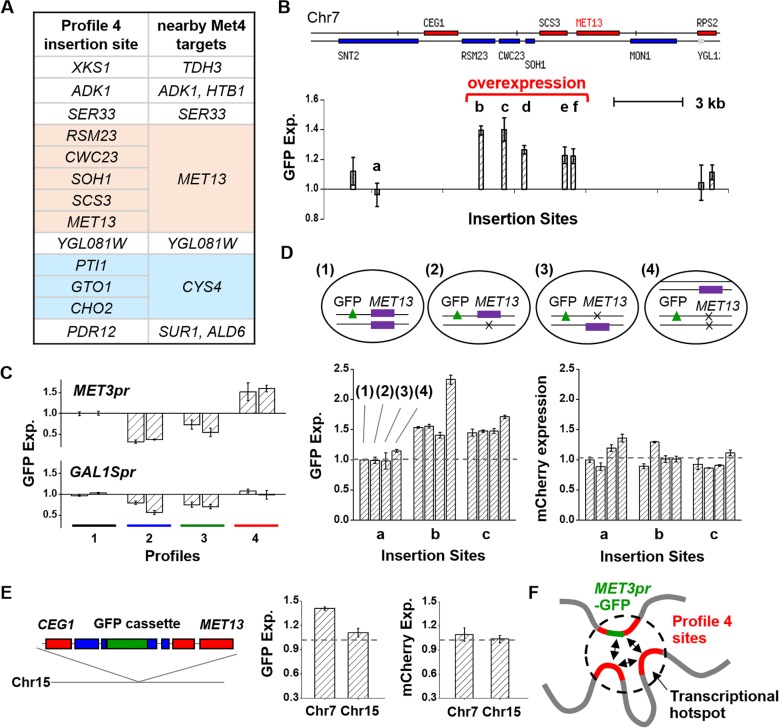
Overexpression in profile 4 is not due to local neighboring genes.A) Reporter insertion sites in profile 4 strains (left column). The insertion sites are either within or near Met4-targeted genes (right column). Some of these sites are close to each other in the genome (highlighted in colors). B) A group of the profile 4 insertion sites near the MET13 gene on Chr7. MET3pr-GFP shows overexpression when inserted over a ~5kb region including multiple adjacent genes (from “b” to “f”). “a” is a nearby site profile 1 site. C) Promoter swapping test. We selected two strains from each profile and integrated the GFP reporter driven by the GAL1Spr instead of the MET3pr. GAL1Spr-GFP at profile 4 sites do not show overexpression, indicating that the overexpression is specific to the MET3pr. D) Deletion of the MET13 allele does not affect the MET3pr overexpression. We started with three strains containing GFP reporter at site “a” (control), “b”, or “c” (1), and deleted the trans (2) or cis (3) copy of MET13, or both (4). The cluster of four bars in the lower plots correspond to the average GFP or mCherry expression with configurations (1)-(4). None of the MET13 deletion eliminates the GFP overexpression at the “b” and “c” sites. E) GFP overexpression disappears when translocated with neighboring genes to a new genomic locus. The reporter cassette at the “c” site along with neighboring genes (from CEG1 to MET13) was inserted into Chr15. The average GFP expression is reduced to the profile 1 level at this new location (p-value = 0.0038). F) Potential model for profile 4 overexpression. Some profile 4 sites may cluster at a transcriptional “hotspot”, allowing the nearby Met4-targeted genes to gain higher expression.